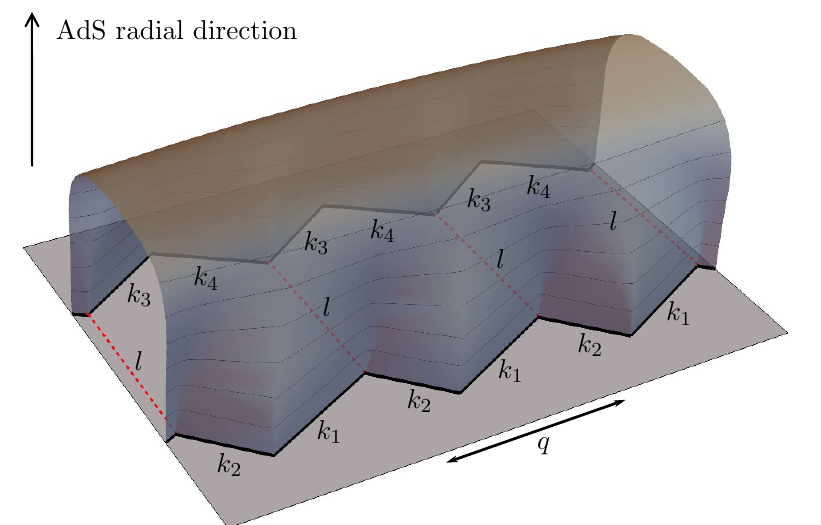
Figure 9 . The T-dual of a string with a cylindrical topology that is holographically dual to a double trace amplitude. It ends at the boundary of AdS 5 along two periodic lines composed of the null external gluon momenta. The worldsheet is subject to a quantum periodicity constraint that restricts it to be periodic in the bulk as well. The period is equal to the total momentum (cid:13)ow through the cylinder, q in (4.3). The separation between the two lines, l , is T-dual to the momentum (cid:13)ow around the cylinder and it is being integrated